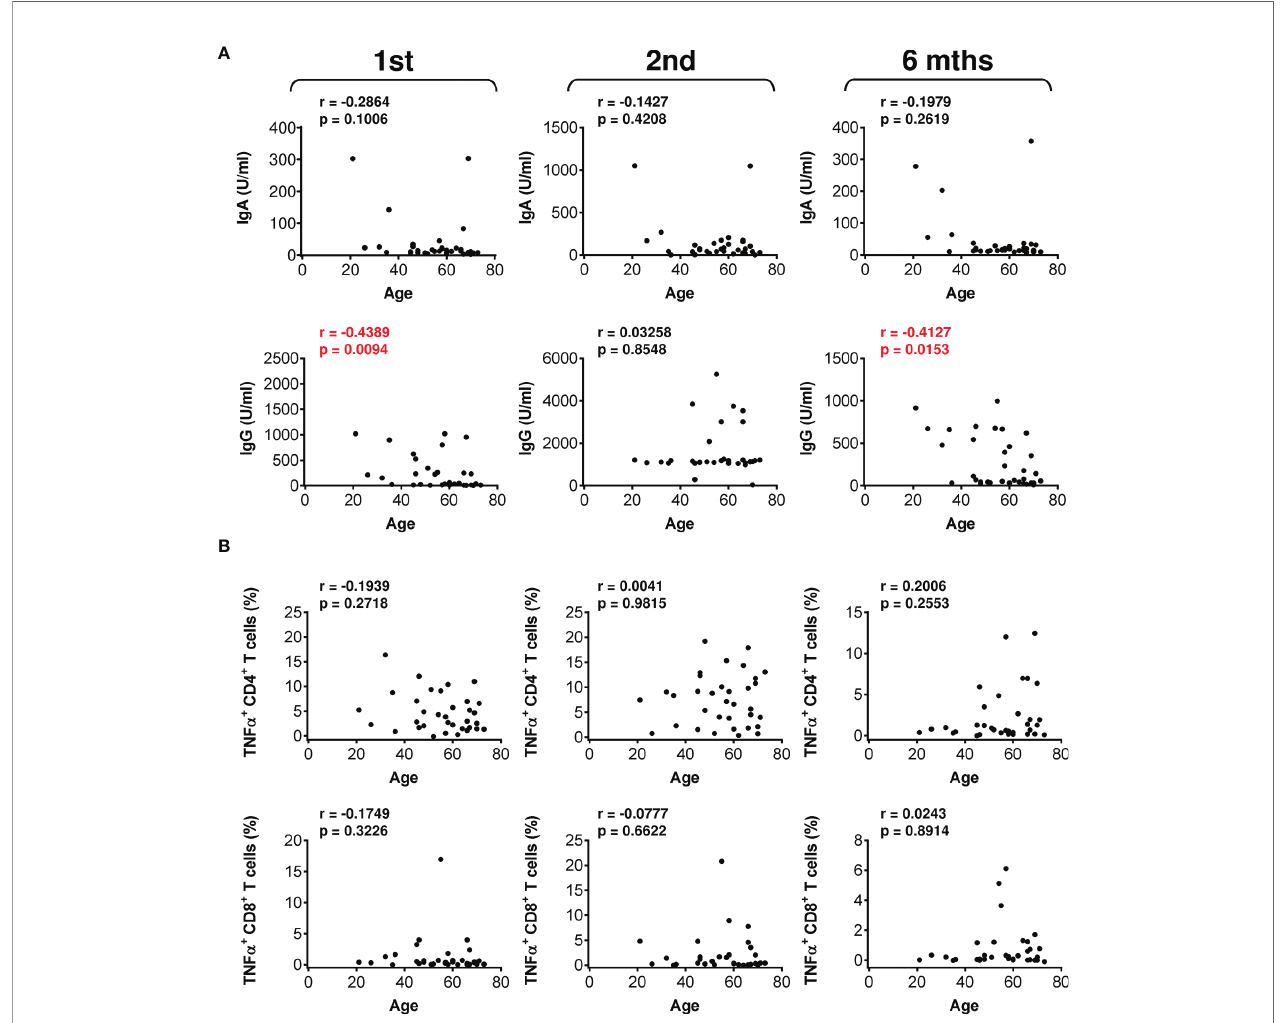
FIGURE 6 | The impact of patient age on the serum levels of anti-RBD antibodies and SARS-CoV-2 spike glycoprotein peptide-reactive CD4 + and CD8 + T cells during and after vaccination. (A) The correlations between patient age and the serum levels (U/ml) of anti-RBD IgA ( top panels ) and IgG ( bottom panels ) antibodies before (1st) and 4 weeks (2nd) and 6 months (6 mths) after the second vaccine dose was administered. (B) The correlations between patient age and the frequencies of peptide-reactive TNF a -producing CD4 + ( top panels ) and CD8 + ( bottom panels ) T cells before (1st) and 4 weeks (2nd) and 6 months (6 mths) after the second vaccine dose was administered. In (A, B) , Spearman ’ s rank-order correlation coef fi cient (r) and the signi fi cance ( p value; n = 34) are